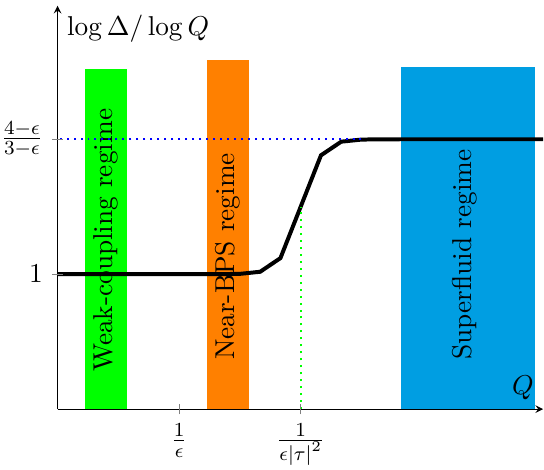
Figure 1 . A schematic plot of the behaviour of the leading power of Q in ∆( Q ) at large Q , i.e. log ∆ / log Q . The three interesting regions (superfluid, BPS, weak-coupling) correspond to three different regions in the Q axis separated by the ticks. The smooth transition of the exponent happens around Q = 1 (cid:15) | τ | 2